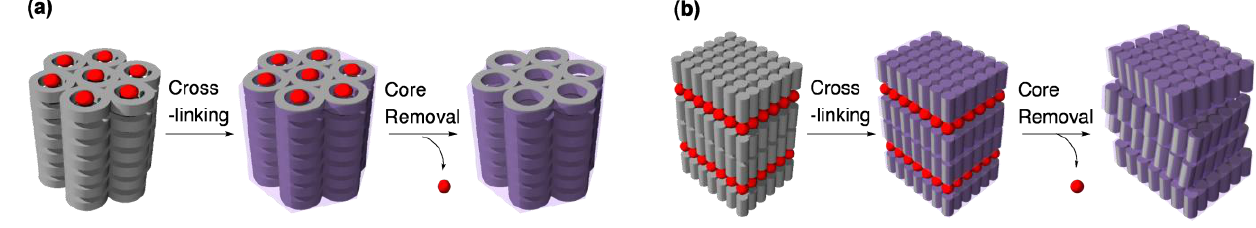
Figure 5. Schematic representation of the fabrication of organic zeolite analogues by the cross-linking of multi-component LCs and the following core removal: ( a ) hexagonal columnar phase and ( b ) lamellar phase.